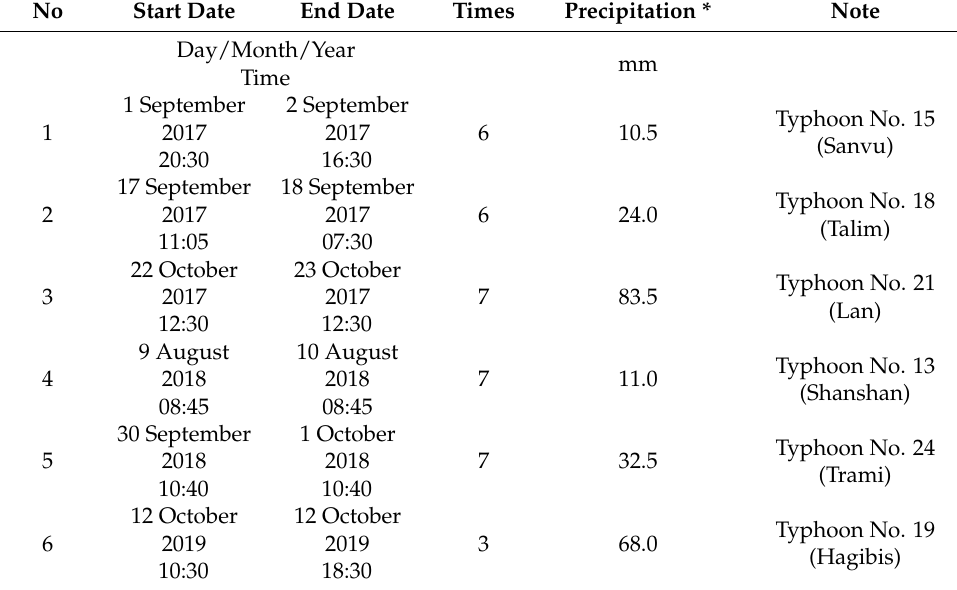
Table 1. Details of sampling periods used to collect high-flow river samples with high-SS concentra-